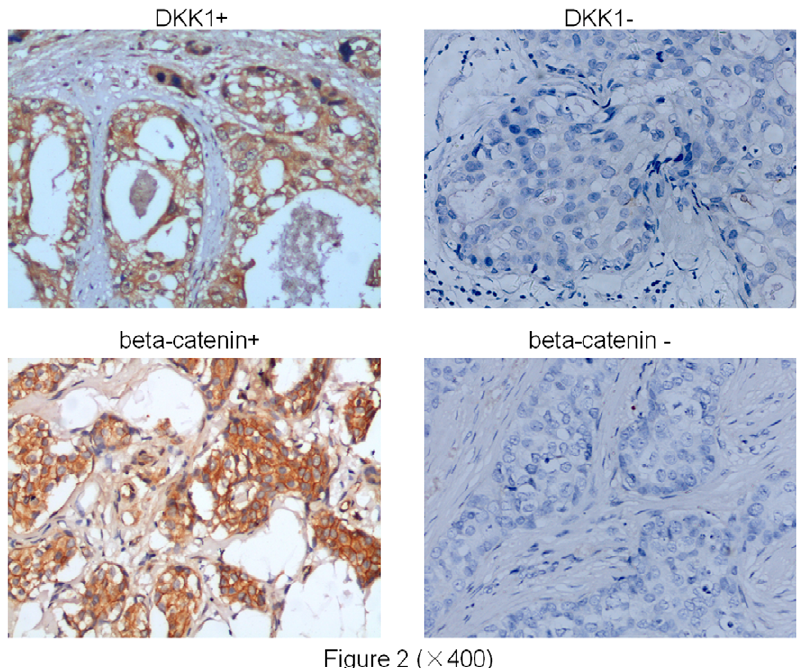
Figure 2. Cytoplasmic immunostaining of DKK1 and beta-catenin in carcinomas. A) Positive immunostaining of DKK1 in an invasive ductal breast carcinoma, 6 400 magnification. B)Negative immunostaining of DKK1 in another invasive ductal breast carcinoma, 6 400 magnification. C) Positive immunostaining of beta-catenin in an invasive ductal breast carcinoma, 6 400 magnification. D) Negative immunostaining of beta-catenin in another invasive ductal breast carcinoma, 6 400 magnification.